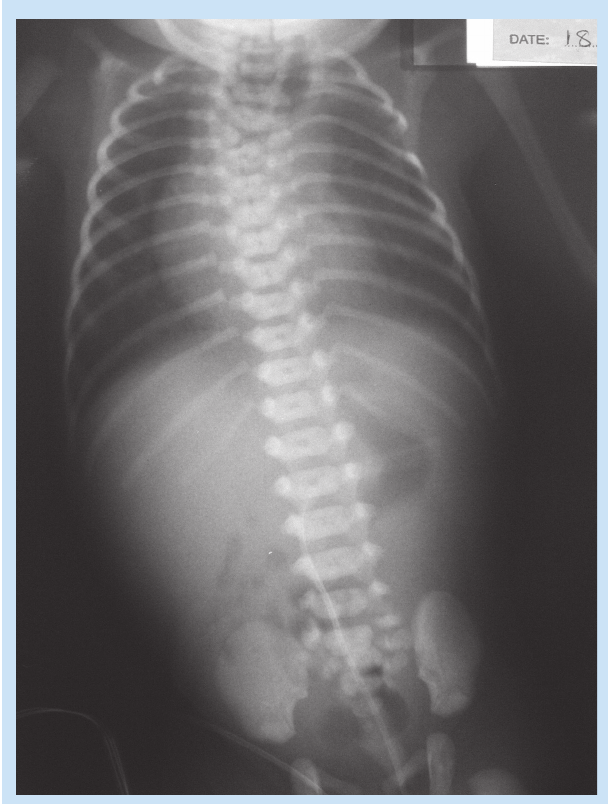
Fig. 1. Abdominal and chest X-ray demonstrating deviation of the umbili- cal venous line, curled up nasogastric tube in the oesophageal pouch and dorsal spine hemivertebrae.